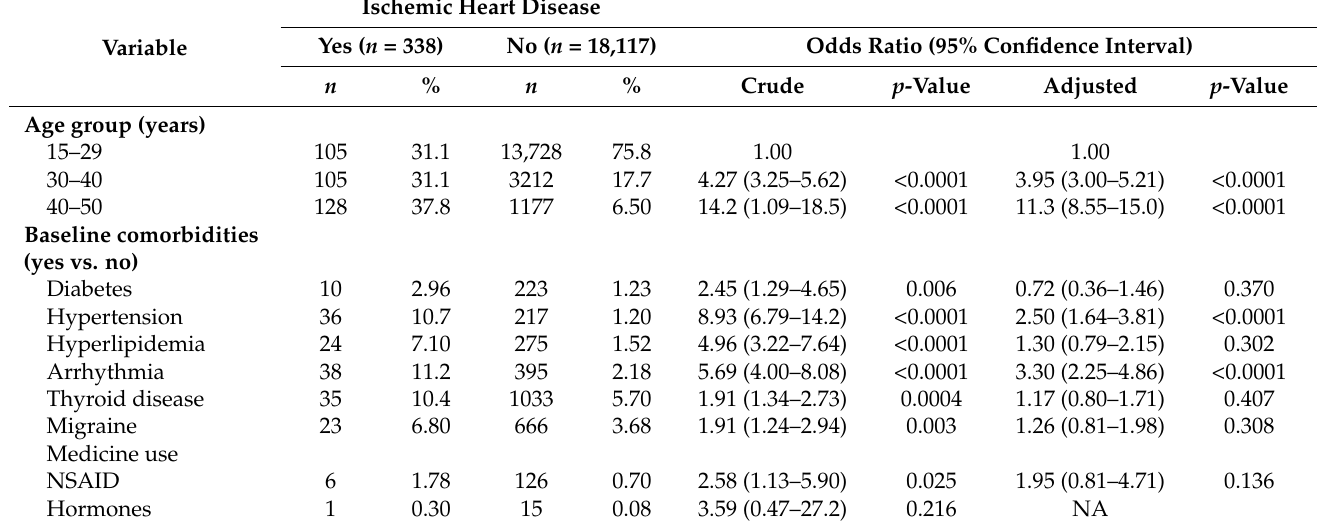
Table 3. Nested case-control analysis for factors associated with ischemic heart disease in the primary dysmenorrheal